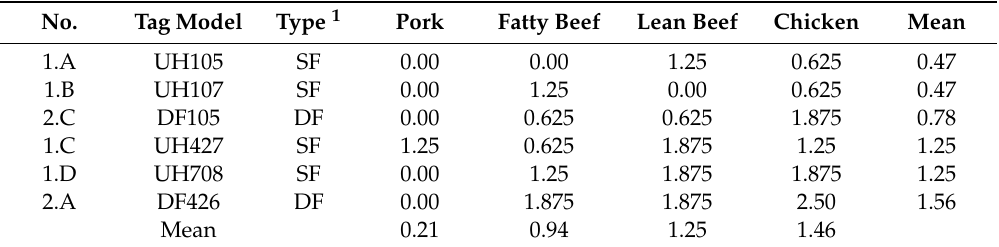
Table 5. Minimum tag-to-meat distances (mm) required to read each UHF tag, considering the Single or Dual Frequency tag model and the four meat types.